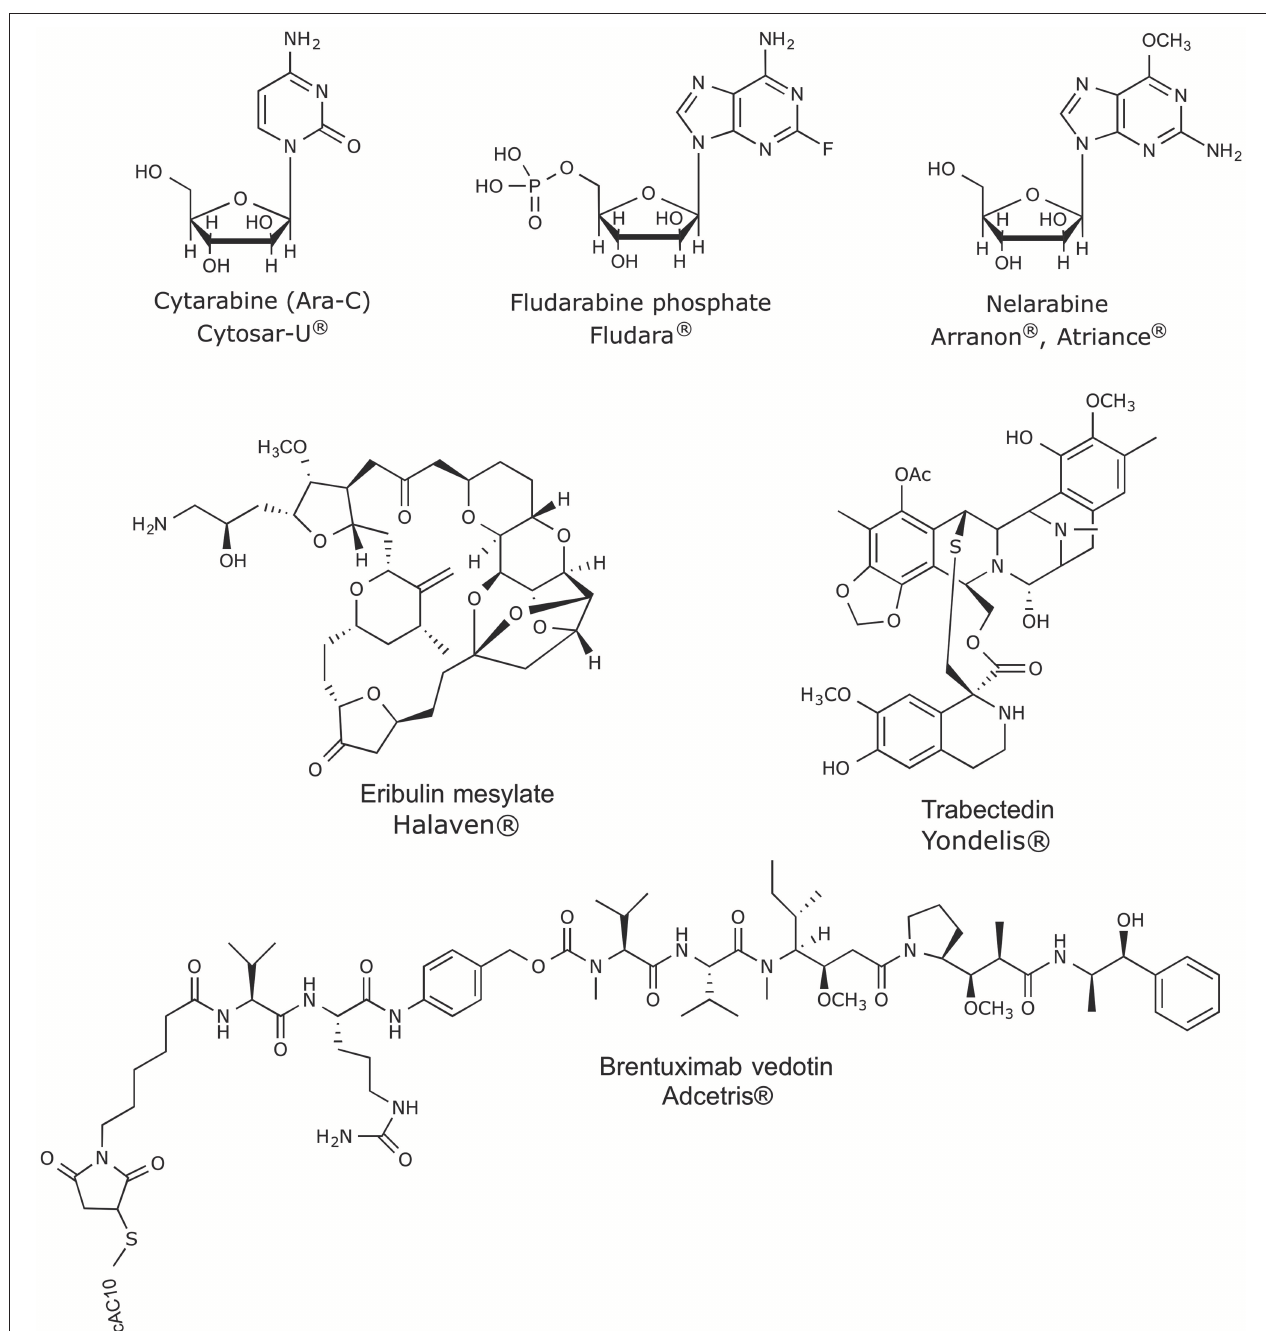
FIGURE 3 | Chemical structures of anticancer marine-derived drugs in the market.